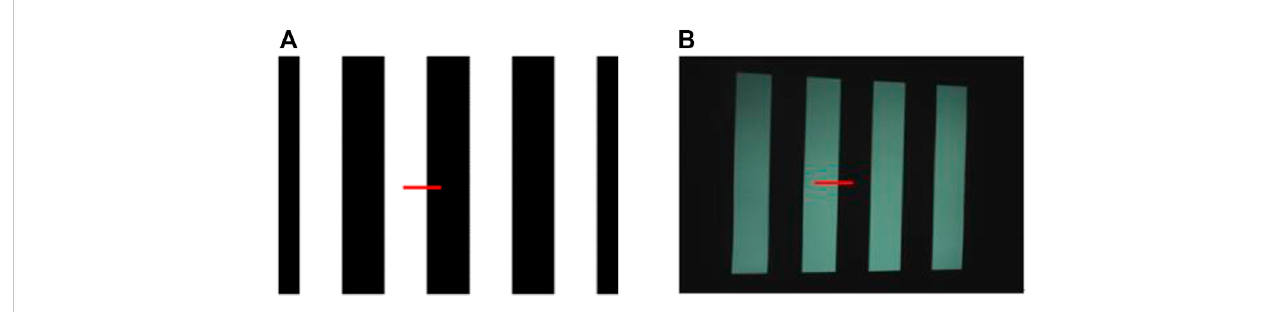
FIGURE 5 The standard image of Gray code and image projection. (A) Standard Gray code; and (B) Projection image of plane.